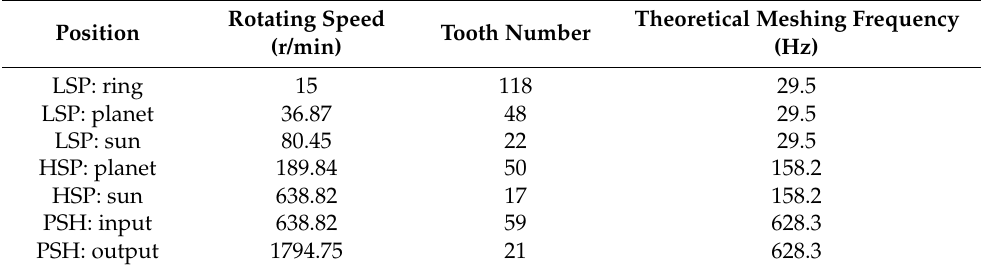
Table 7. Theoretical meshing frequencies at the rated rotating speed of 15 rpm.